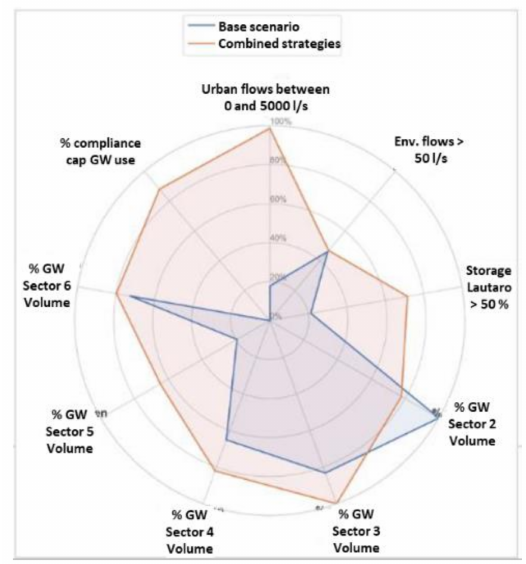
Figure 12. Impact indicators for the combinatory of water management strategies prioritised through the participatory